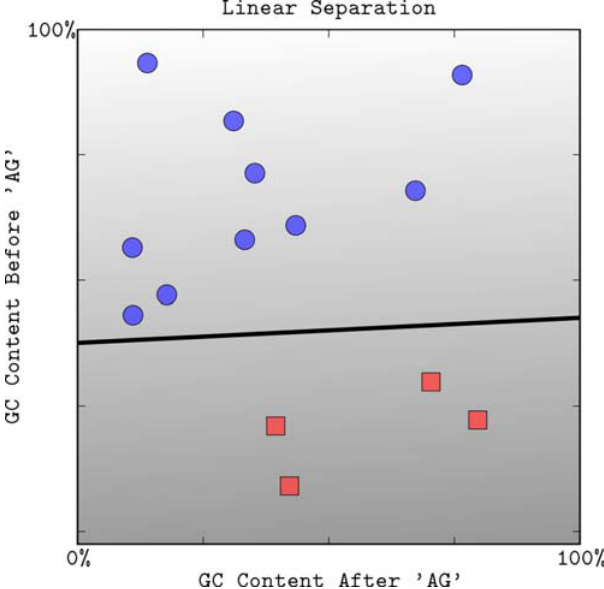
Figure 1. A linear classifier separating two classes of points (squares and circles) in two dimensions. The decision boundary divides the space into two sets depending on the sign of f ( x )= Æ w , x æ+ b . The grayscale level represents the value of the discriminant function f ( x ): dark for low values and a light shade for high values.